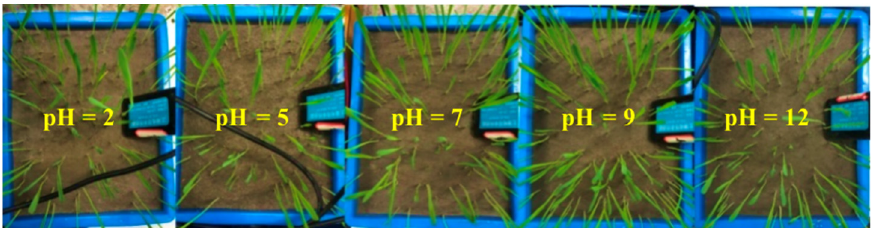
Figure 9. Oat growth in the soil treated with 0.25% XG (on the 7th day).